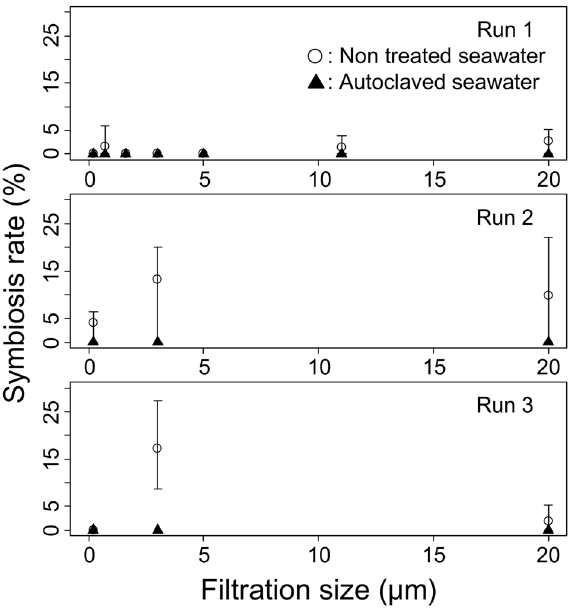
Figure 3. Symbiosis rates of Tridacna crocea in the filtration autoclave experiments. Showing what percentage of the seeds reared in autoclaved and non autoclaved seawater filtered at various levels established a symbiotic relationship with Symbiodinium. Presented with the mean (circle and cross) and range (vertical line).